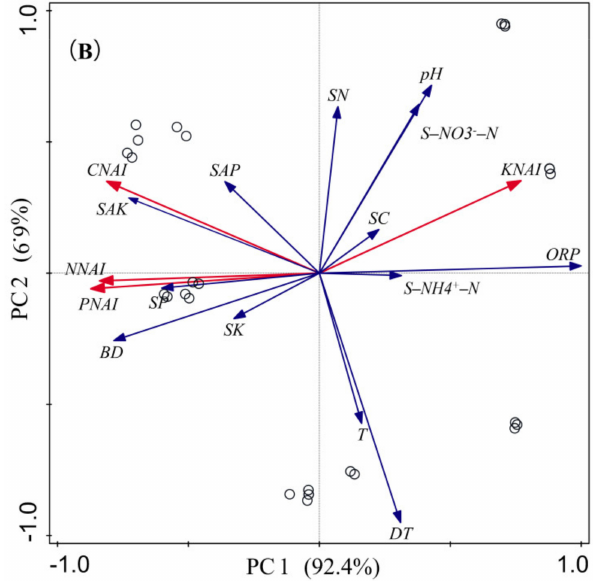
Figure 8. Principal component analysis (PCA) applied to data of E. crusgali ( A ) and B. tripartita ( B ) litter nutrient change during decomposition and different exoteric factors. CNAI: carbon NAI; NNAI: nitrogen NAI; PNAI: phosphorus NAI; KNAI: potassium NAI; BD: buried depth; DT: decom- position time; ORP: soil oxidation–reduction potential; T: soil temperature; pH: soil pH; SC: total soil carbon; SN: total soil nitrogen; SP: total soil phosphorus; SK: total soil potassium; SAP: soil available phosphorus; SAK: soil available potassium; S–NH4 + –N: soil ammonium nitrogen; S–NO3 − –N: